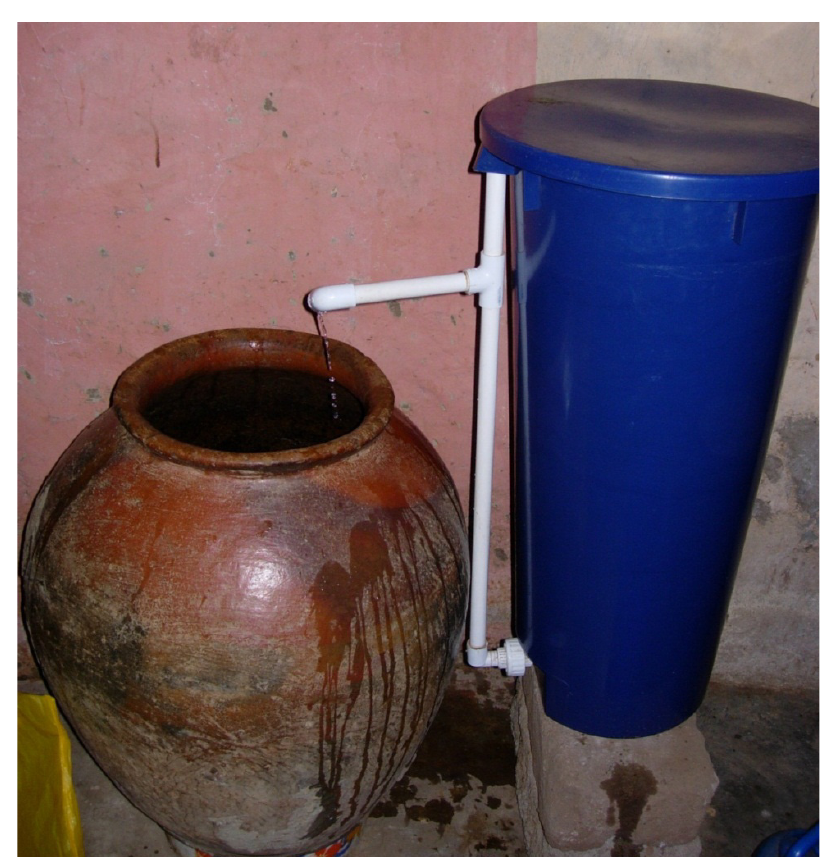
Figure 1. Typical set-up of the plastic BSF in a household in rural Tamale, Ghana